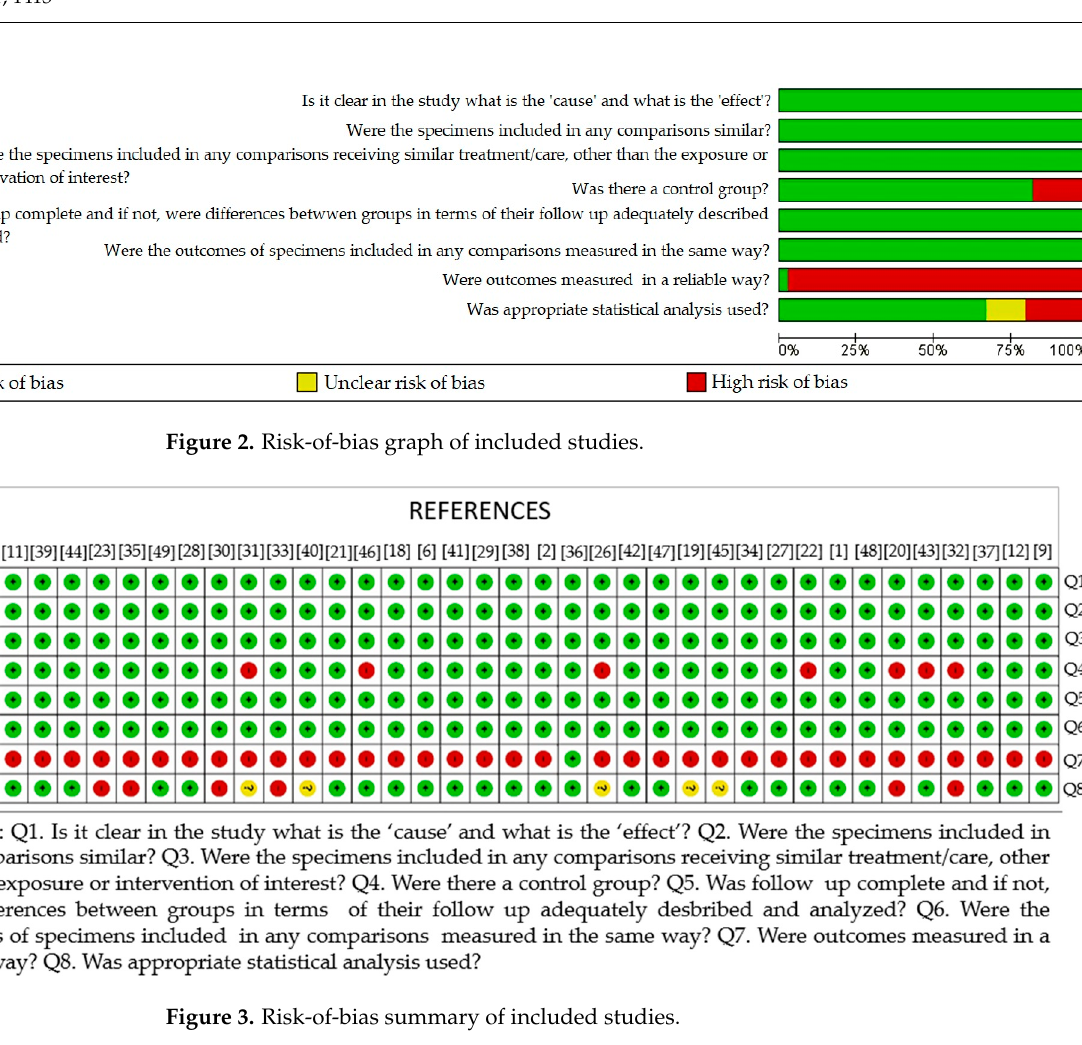
Figure 3. Risk-of-bias summary of included studies.